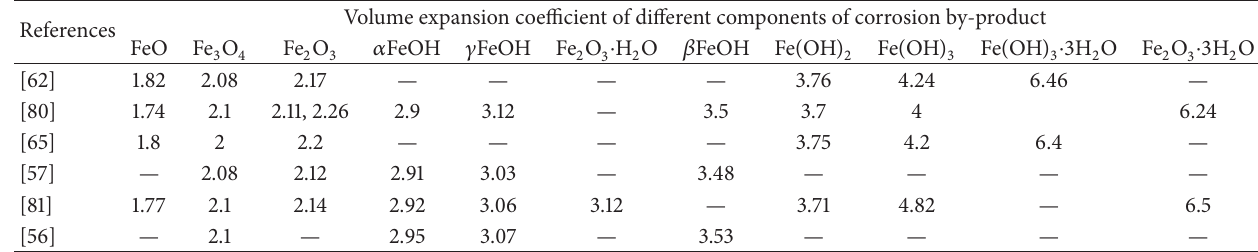
Table 6: Volume expansion of corrosion by-product components.